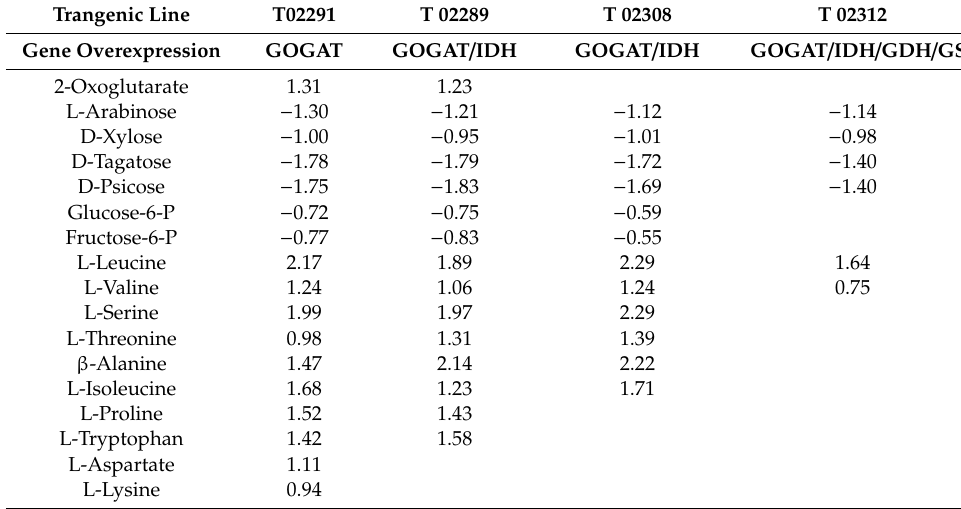
Table 1. Metabolites exhibiting significant changes ( p ≤ 0.05) between the WT (A188) and the di ff erent transgenic lines overexpressing NADH-GOGAT (construct T02291) and stacked with NAD-IDH (construct T02289), NAD-IDH + NADH-GDH1 (construct T02308) and NAD-IDH + NADH-GDH1 + GS1.3 (construct T02312). Results are expressed in Log of the Fold